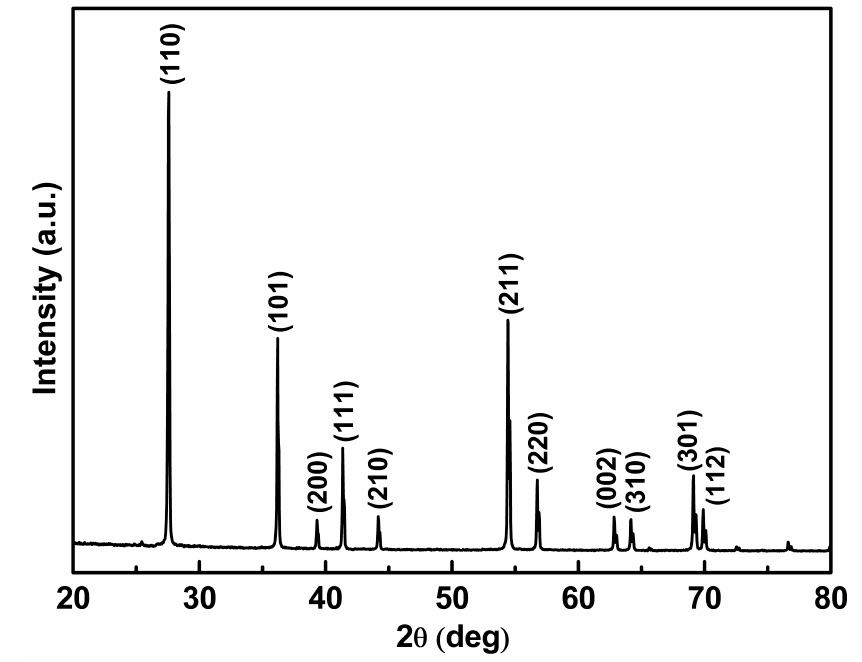
Figure 5. XRD spectrum of Fe-doped TiO 2